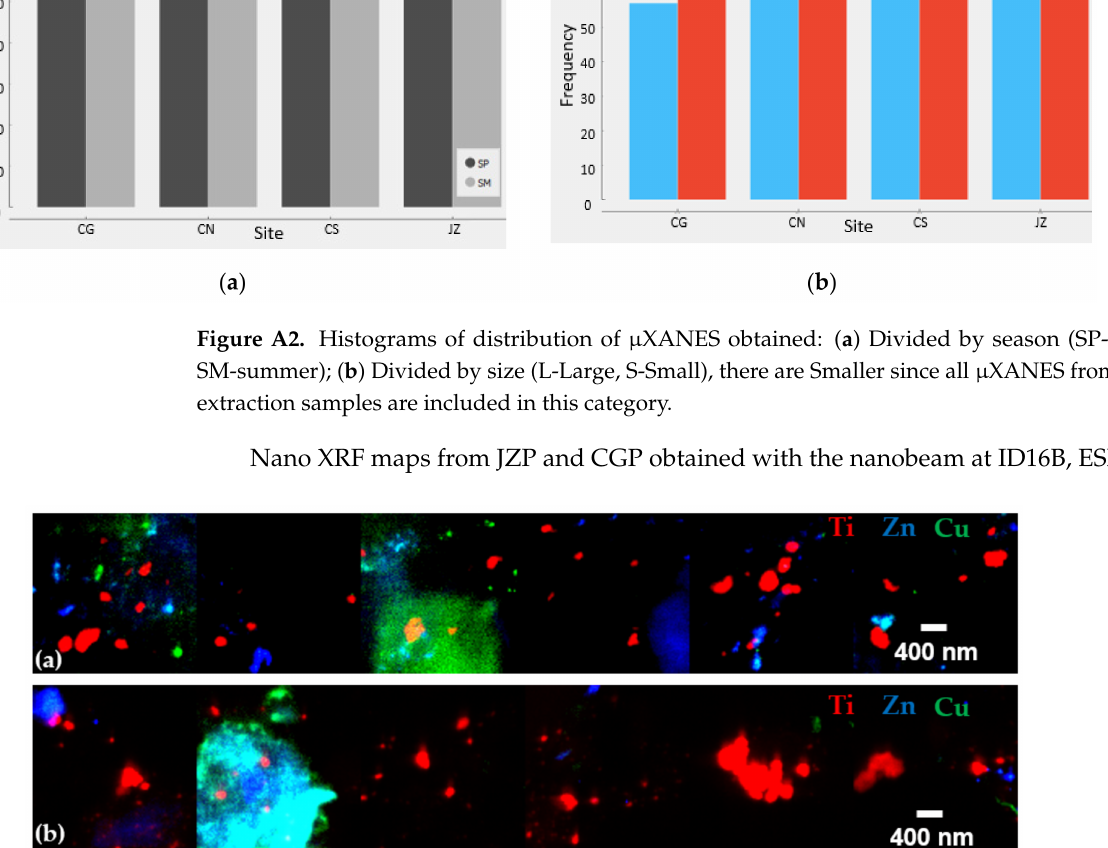
Figure A3. Nanomaps from sludge water extracts: ( a ) Juarez Spring; and ( b ) Casas Grandes